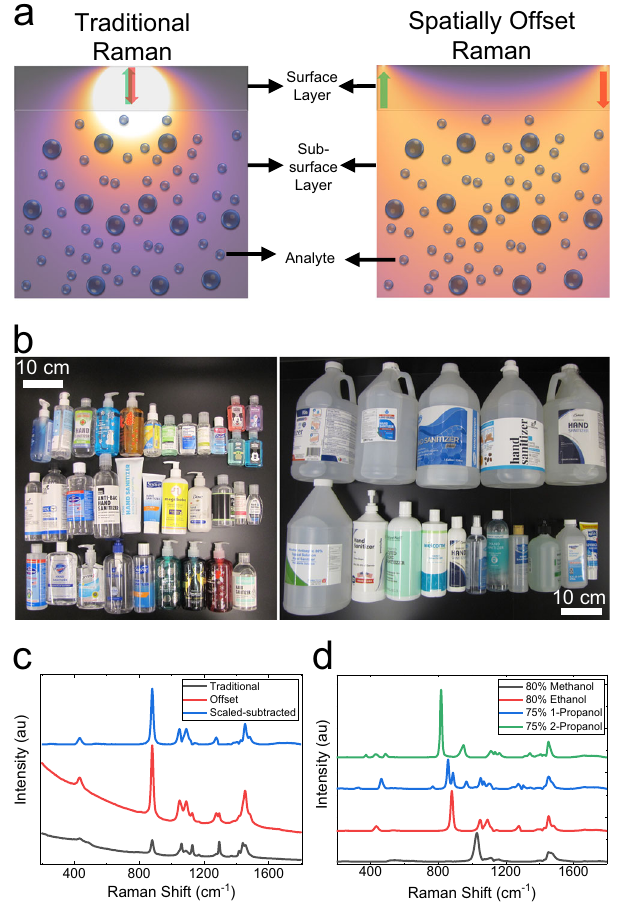
Fig. 1 Through-container spectroscopy of hand sanitizers using SORS. a Schematic representation of the principle of spatially offset Raman. b Images from commercial hand sanitizer products used in the study. c Traditional and offset spectra, and their scaled subtraction from an ethanol-based hand-sanitizer solution. d Scaled – subtracted spectra of hand-sanitizers based on four alcohols used in the